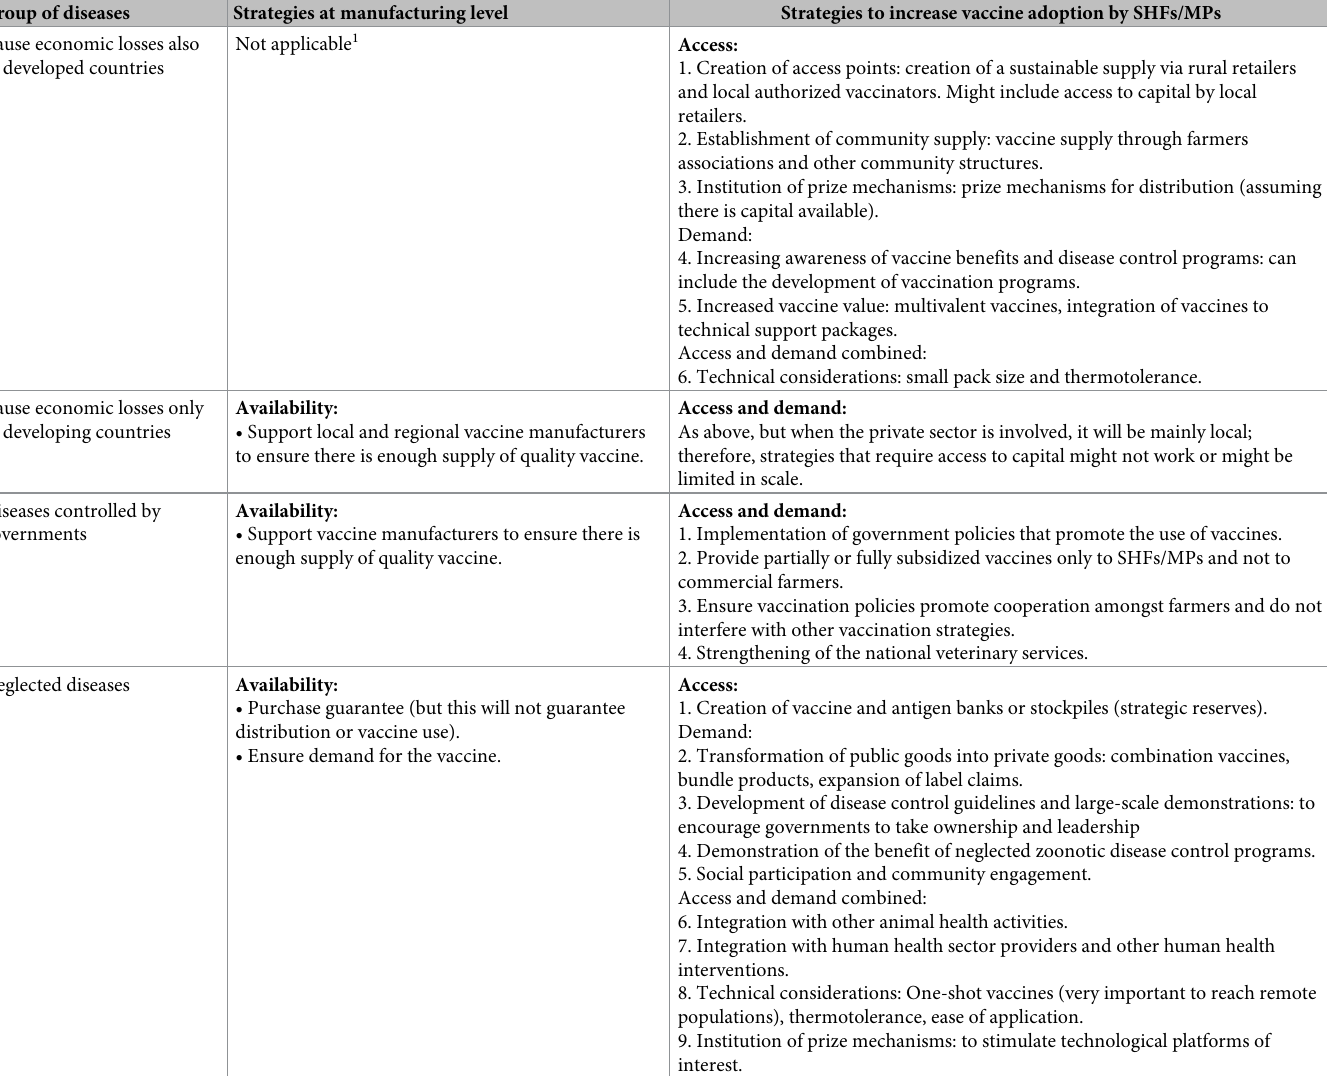
Table 2. Potential strategies to secure vaccine production and increase vaccine use by SHFs and/or MPs according to the different disease categories. Strategies are generic and might not apply to all diseases in each group, or in all countries. The different strategies need to be considered within local, national, and regional contexts. Some strategies may only provide a partial solution. See text for